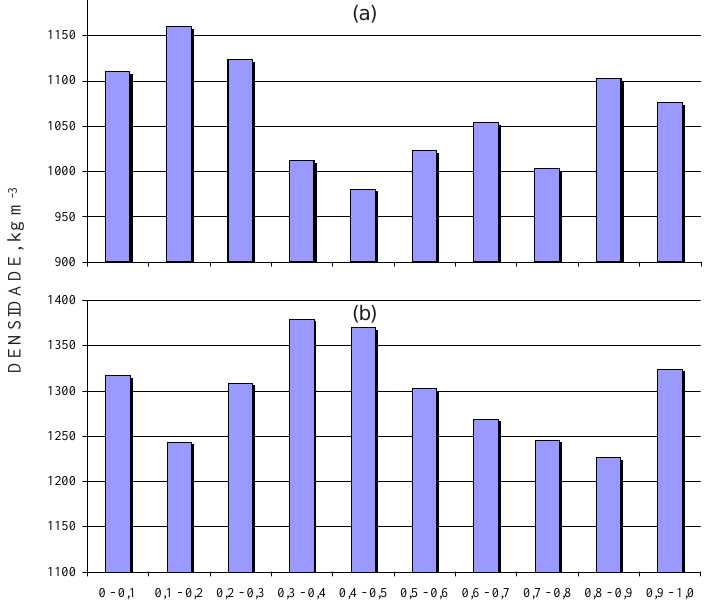
Figura 1. Densidade do solo para as camadas do Latossolo Amarelo distrófico (a) e do Latossolo Vermelho distroférrico típico